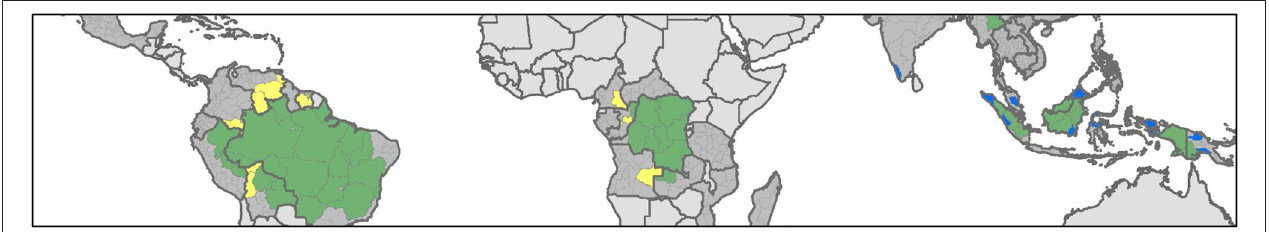
FIGURE 5 | The top 50 second-tier jurisdictions for projected emissions from deforestation shifts with and without consideration of authority score. Green = top 50 jurisdictions in both unweighted and weighted projected emissions. Yellow = top 50 jurisdictions in unweighted projected emissions, 2020–2050 (Busch et al., 2019) only. Blue = top 50 jurisdictions in projected emissions weighted by authority score